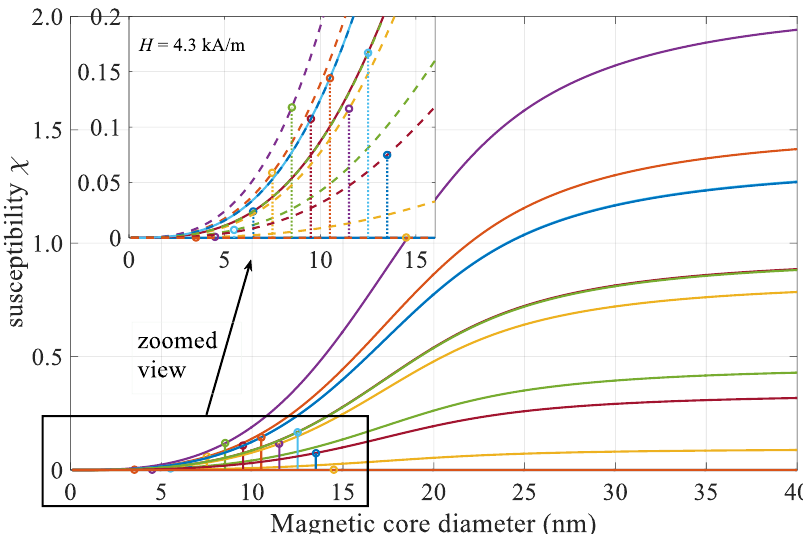
Figure 6. Magnetic nanoparticle chord susceptibility size dependence for magnetic field of 4.3 kA/m.